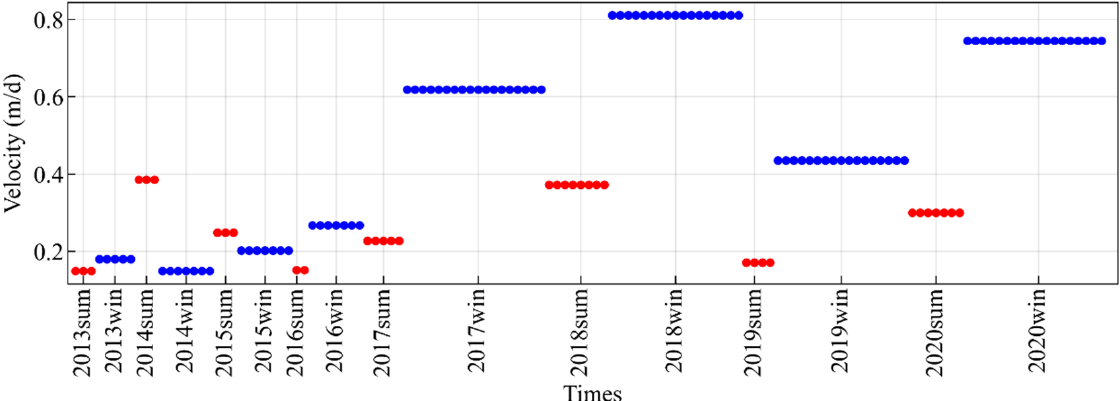
Figure 5. Centerlines motion patterns for five STGs (including NE2, NE4, NE5, SW1, and SW2) from 2013 to 2021. The seasonal characteristics of glacier surface velocities were monitored using an application for cross-correlation feature tracking of Landsat OLI (15 m) and Sentinel-2 (10 m) images. The red circle represents summer and the blue circle represents winter.